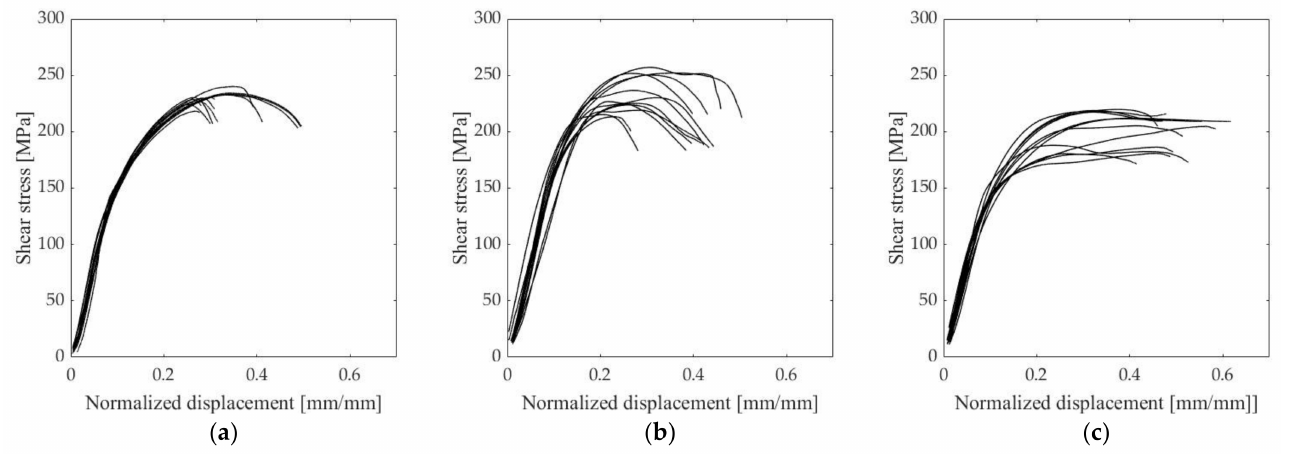
Figure 5. Shear stress-normalized displacement of test specimens: ( a ) S355-IN600 vacuum brazed; ( b ) S1100-IN718 HIP; and ( c ) S355-IN718 HIP. Table 5. Shear strength of the test specimens ( n = number of samples).